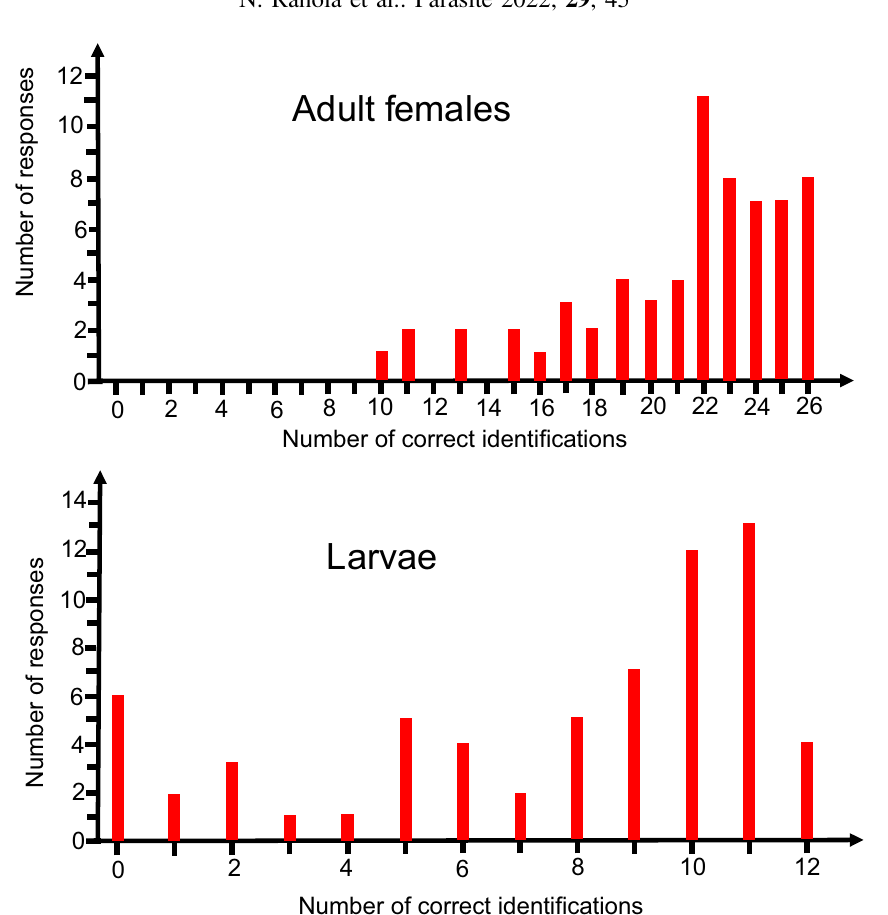
Figure 3. Distribution of the number of responses with regard to the number of correct identi fi cations of mosquito species for 26 adult females and 12